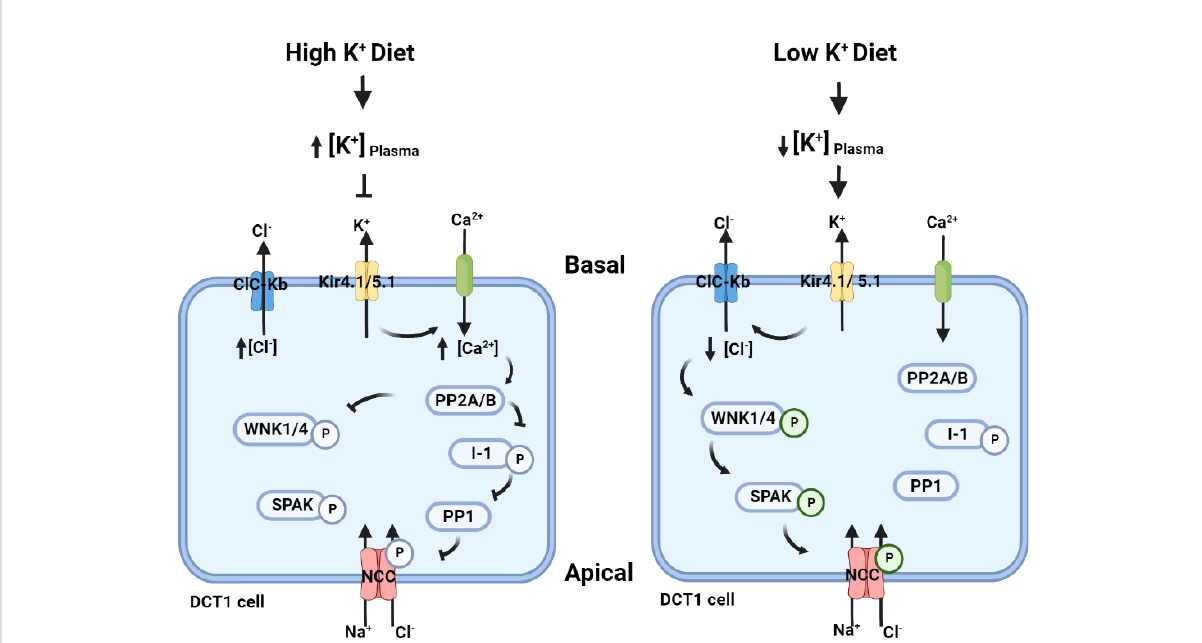
FIGURE 3 The putative “ renal - K + switch ” mechanism. In the basolateral membrane, K + channels Kir4.1/5.1 and a Cl - channel ClC-Kb can indirectly regulate NCC activity by modifying intracellular [Cl - ] and hence the autophosphorylation of WNKs (145). High dietary K + intake increases plasma [K + ], resulting in reduced K + extrusion by Kir4.1 and plasma membrane depolarisation of the early DCT (DCT1). This limits Cl - removal by ClC-Kb and hence intracellular Cl - mediated inhibition of the WNK-SPAK-NCC pathway remains (146 – 148). In addition, the effects on Kir4.1 may facilitate extracellular Ca2 + in fl ux across the membrane via an unknown voltage-gated Ca2 + channel. This increased intracellular Ca2 + is proposed to activate protein phosphatase 2 (PP2A/B) to inhibit WNK (149, 150), and potentially PP2A/B may modulate the protein phosphatase 1 inhibitor (I- 1) protein phosphatase 1 (PP1) pathway leading to NCC dephosphorylation (151 – 153). In contrast, a low K + diet reduces the plasma K + concentration. Low extracellular K + results in cellular K + extrusion by Kir4.1 leading to membrane hyperpolarization and release of Cl - from the cell through ClC-Kb. The subsequent reduction in intracellular Cl - relieves the inhibition of WNK4 autophosphorylation and allows the WNK- SPAK pathway to phosphorylate and activate NCC, leading to more NaCl